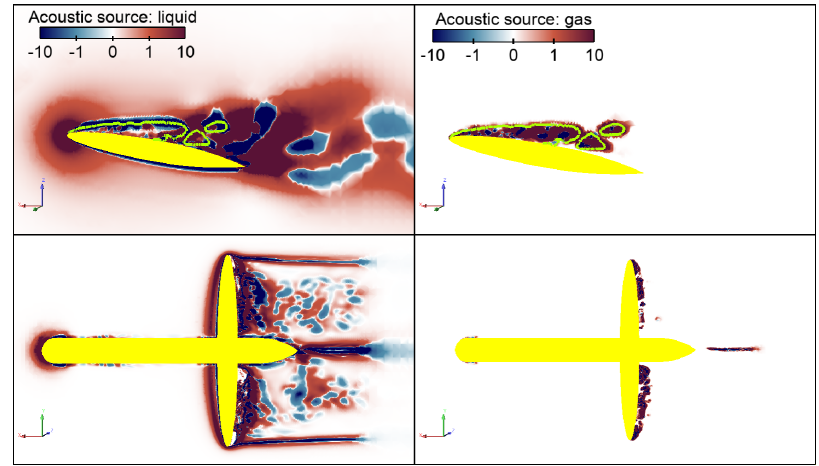
Figure 1. Illustration of acoustic source term contributions from liquid and gas phases individually. A snapshot from an EE flow solution. Frames on the left show the liquid phase and frames on the right show the gas phase contributions. Top frames are at the y -plane taken at midchord of the left wing, and bottom frames are at the z -plane taken in the middle of the cavitator. The green lines denote a contour of α g = 0.1. The flow is from left to right.